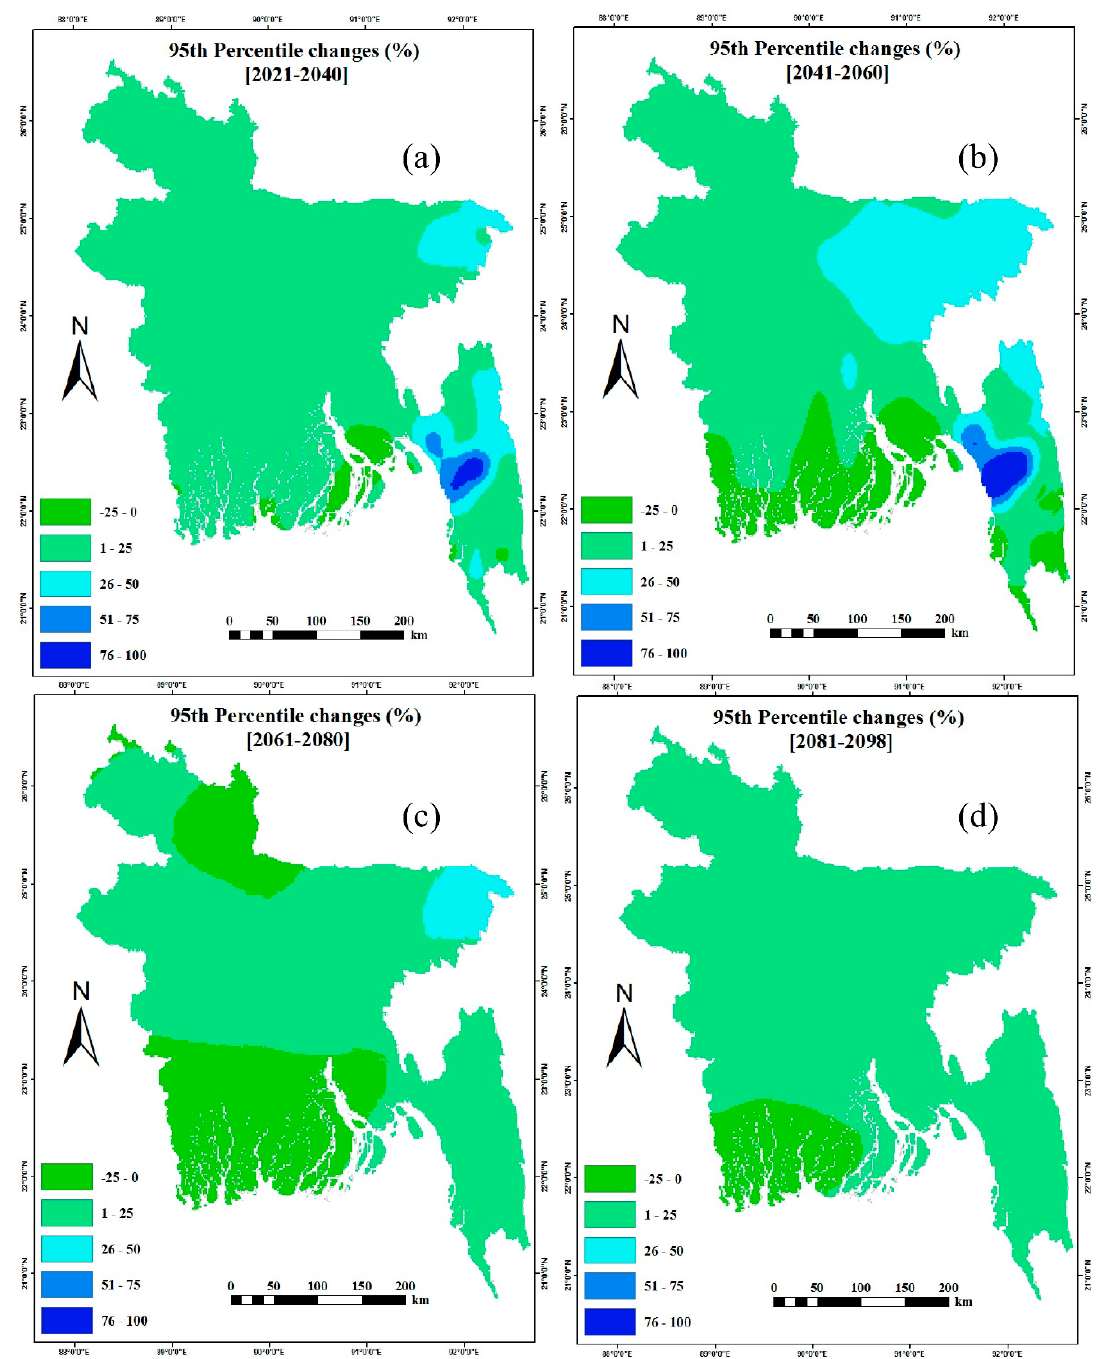
Figure 9. Spatial distribution of changes (%) in the mean 95th percentile rainfall during different time periods.